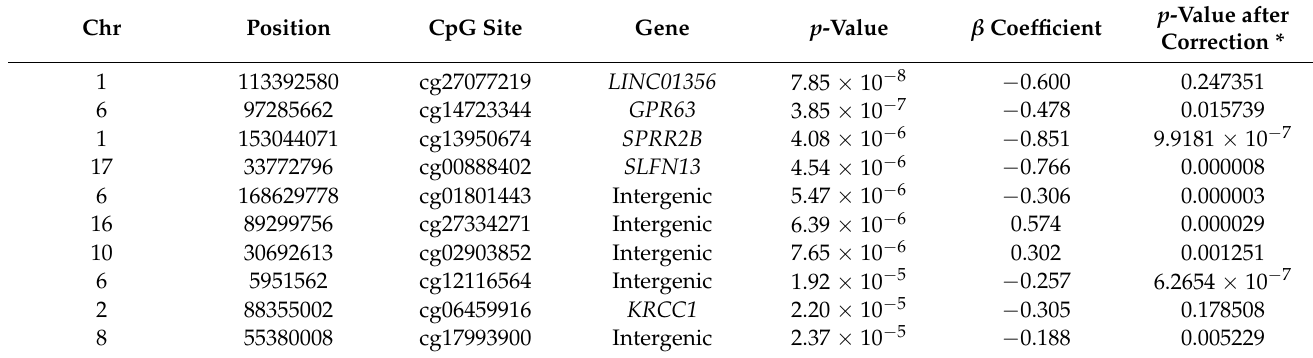
Table 2. List of top ten differentially methylated positions (DMPs) associated with current suicidal ideation severity. Methylation at these CpG sites were identified to be associated with suicidal ideation severity, as a continuous phenotype, with a linear regression-based